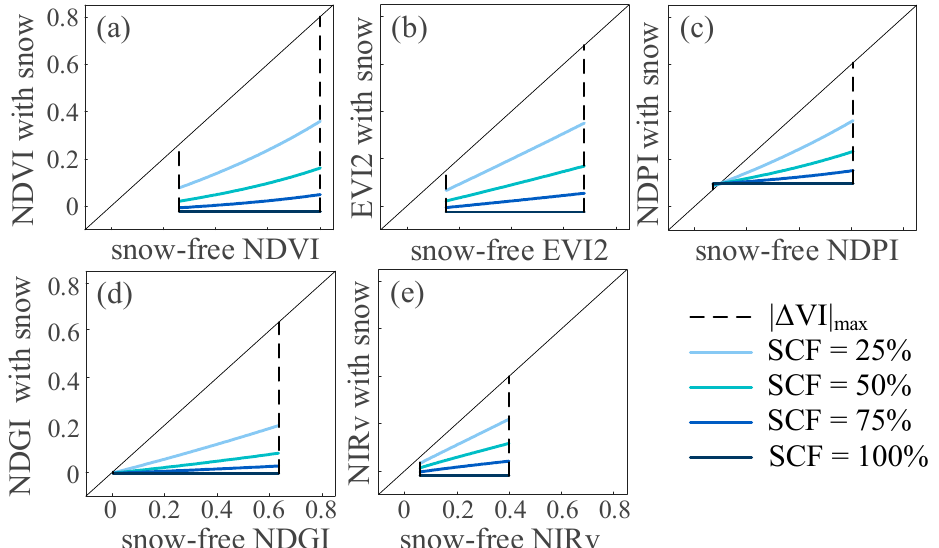
Figure 10. Comparison of simulated VIs under different SCFs with snow-free cases. ( a – e ) are the changes of the five VIs as the FVC increases from 0 to 1 under different SCF conditions.